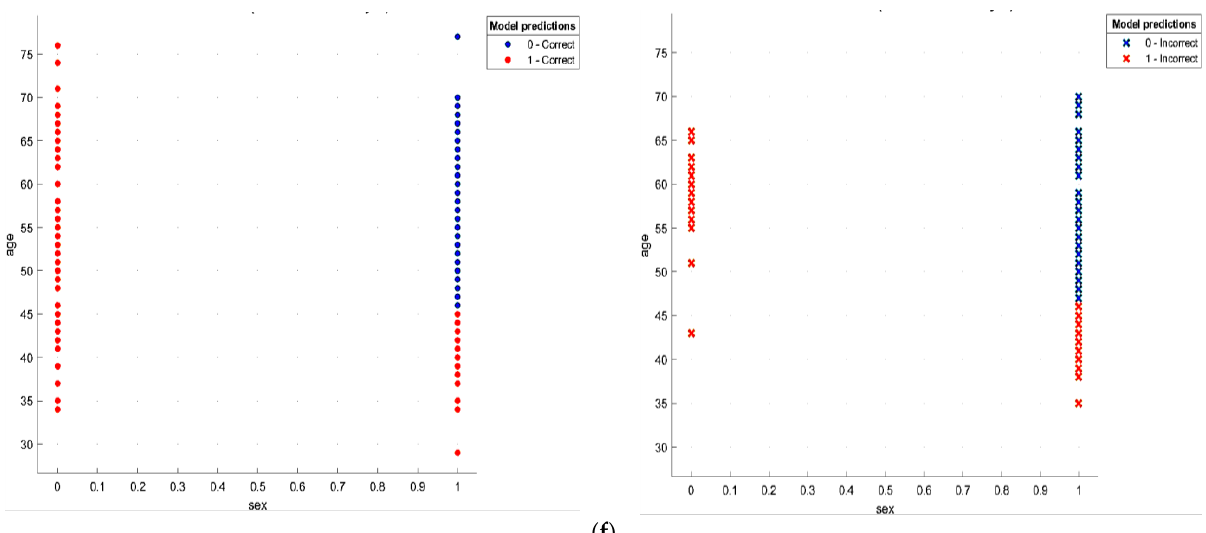
Figure 4. ( a ) SVM model with the correct and incorrect predictions concerning the features ‘age’ and ‘sex’. ( b ) KNN model with the correct and incorrect predictions concerning the features ‘age’ and ‘sex’. ( c ) AdaBoost model with the correct and incorrect predictions concerning the features ‘age’ and ‘sex’. ( d ) Bagged tree model with the correct and incorrect predictions concerning the features ‘age’ and ‘sex’. ( e ) Logistic regression model with the correct and incorrect predictions concerning the features ‘age’ and ‘sex’. ( f ) Gaussian naive Bayes model with the correct and incorrect predictions concerning the features ‘age’ and ‘sex’.